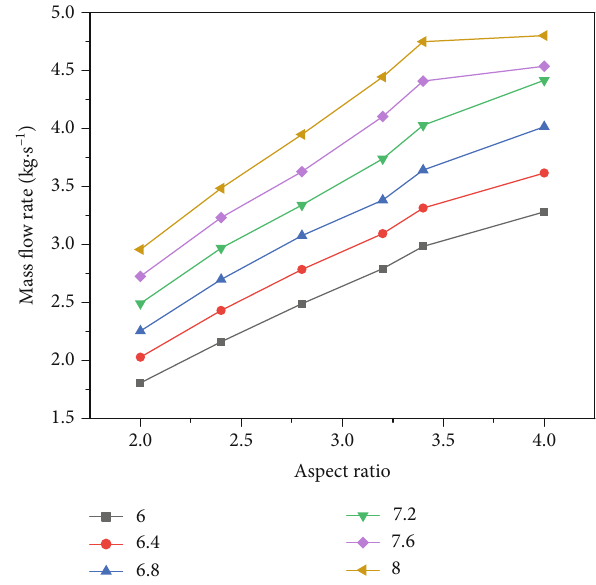
Figure 6: Mass fl ow rate with di ff erent aspect ratios and slope angles at an opening length of